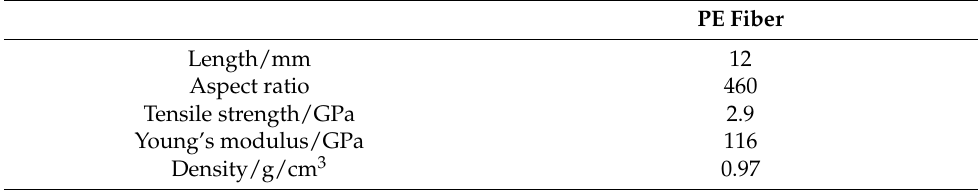
Table 2. Physical and mechanical performances of PE